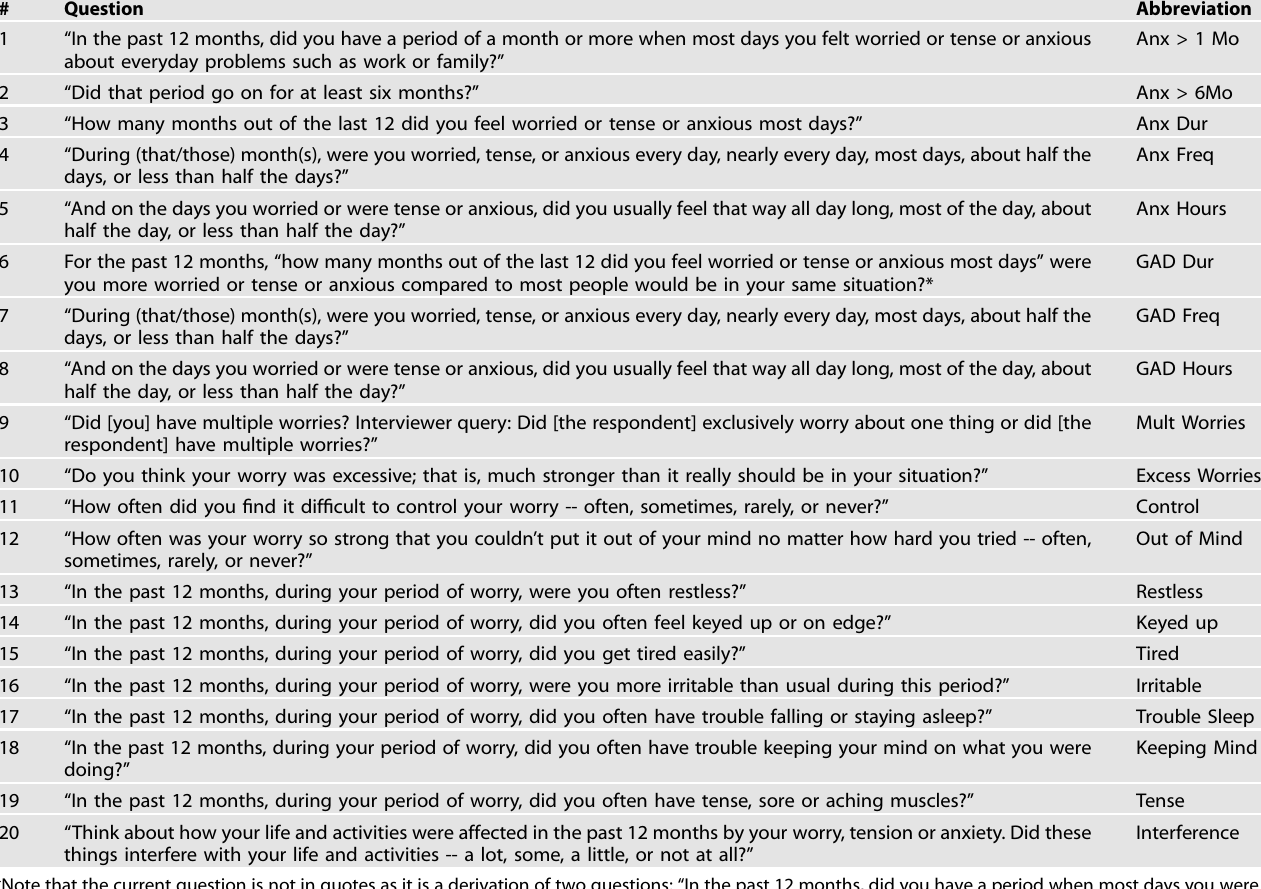
Table 1. CIDI Interview Questions to Assess Generalized Anxiety